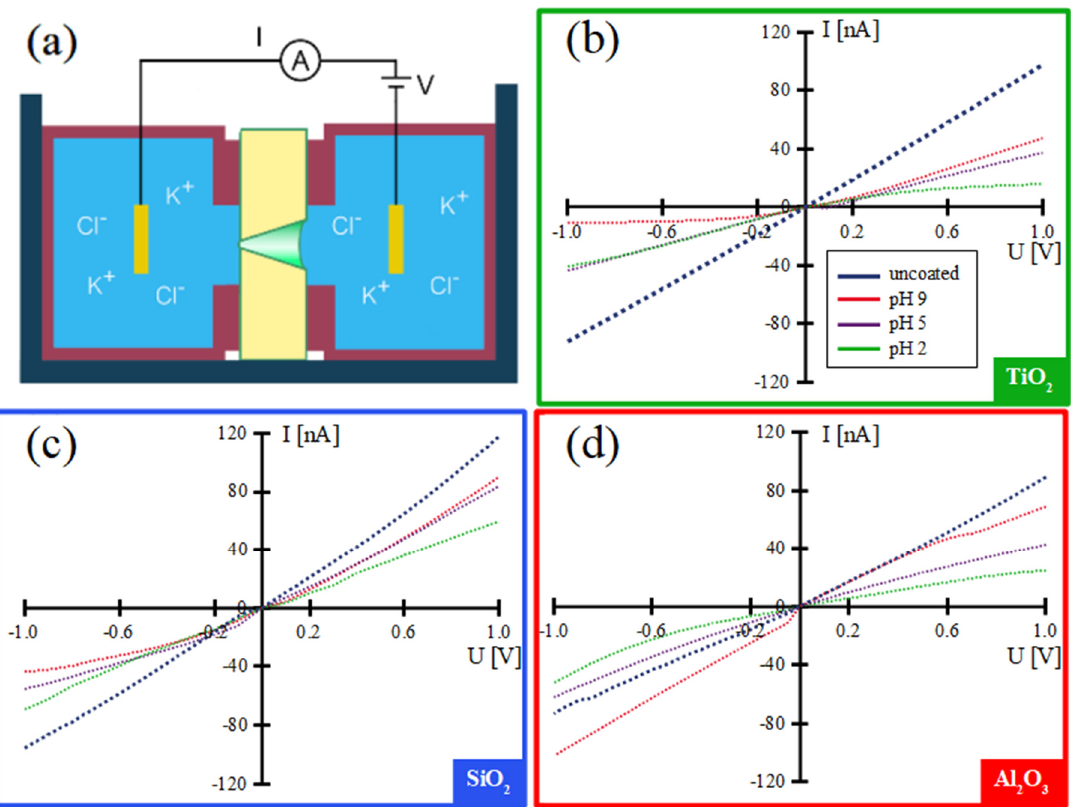
Figure 2. Scheme of electrochemical cell for I–V measurements ( a ). I–V curves for single conical nanochannels uncoated (blue) and coated with ~15 nm TiO 2 ( b ), SiO 2 ( c ), and Al 2 O 3 ( d ) at different pH values. I–V curves were recorded in a 1 M KCl solution adjusted to pH values of 2 (green), 5 (purple), and 9 (red).